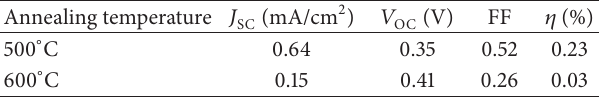
Table 2: Photoelectrochemical parameters of DSSCs based on TiO nanotube arrays annealed at different